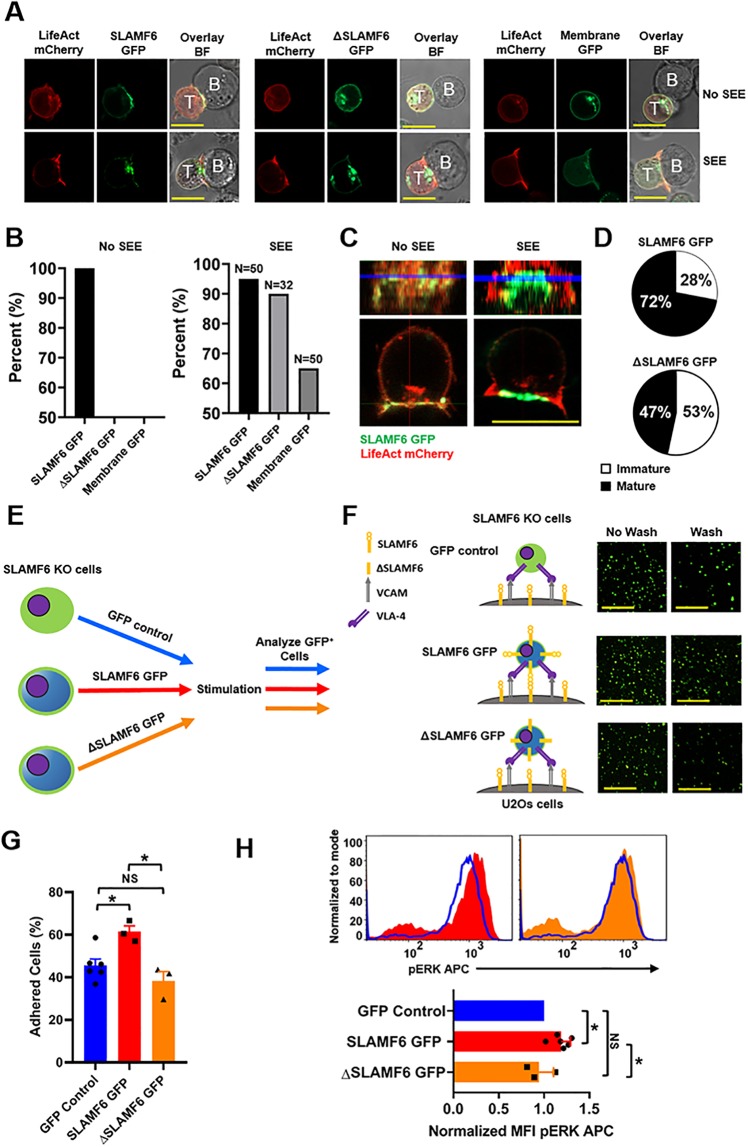
The SLAMF6 ectodomain is not required for SLAMF6 presence immunological synapse, but contributes to its co-receptor function.(A) Jurkat T cells were transfected with LifeAct mCherry and SLAMF6 GFP, ΔSLAMF6 or membrane GFP. Raji B cells (top row) or Raji B cells loaded with SEE (bottom row) were co-cultured with the transfected Jurkat T cells. Images are representative of at least 32 cells from a least two independent experiments. Scale bar is 10μm. Actin clearance was defined as a mature IS. If actin was not cleared from the IS the synapse was considered immature. Only images with actin clearance were considered for analysis of SLAMF6 presence in the IS when Raji B cells were loaded with SEE. (B) Quantification of SLAMF6 GFP, ΔSLAMF6 or membrane GFP at the point of contact between a Jurkat T cell and Raji B cell (left). Quantification of SLAMF6 GFP, ΔSLAMF6 GFP or membrane GFP at IS between a Jurkat T cell and a SEE loaded Raji B cell (right). (C) SLAMF6 localizes to the PSMAC in mature synapses. (D) The percent of mature and immature synapses for Jurkat T cells transfected with SLAMF6 GFP or ΔSLAMF6 GFP. (E) A schematic of the assay used to analyze SLAMF6 ectodomain function. (F) SLAMF6 KO jurkat T cells were transfected with GFP control, SLAMF6 GFP or ΔSLAMF6 and co-cultured with U2Os cells stably expressing SLAMF6 and VCAM in the presence of αCD3 for 20 min at 37°C. They were then imaged before and after four washes. Scale bar is 100μm. (G) Quantification of number of adhered cells for at least three independent experiments of SLAMF6 KO Jurkat T cells transfected with GFP control, SLAMF6 GFP or ΔSLAMF6 (bottom) (n = 3–6). *p<0.05 for an unpaired student t-test. (H) Representative histograms analyzing pERK APC for SLAMF6 KO Jurkat T cells (top). SLAMF6 KO Jurkat T cells were transiently transfected with GFP control, SLAMF6 GFP or ΔSLAMF6. Cells were treated with αCD3 + cross linker, stimulated at 37° C for 5 min, fixed permeabilized, stained and subjected to flow cytometry. Cells were gated on GFP positive cells and analyzed for pERK APC. Quantification of pERK for at least three independent experiments of SLAMF6 KO Jurkat T cells transfected with GFP control, SLAMF6 GFP or ΔSLAMF6 (bottom) (n = 3–6). *p<0.05 for an unpaired student t-test.